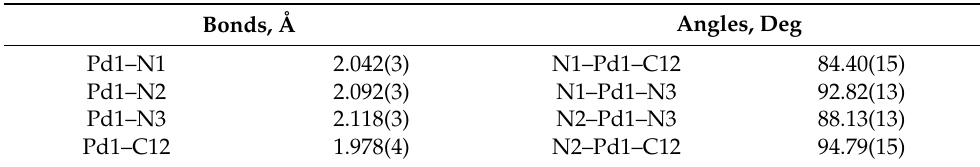
Figure 2. The molecular structure of 2b . Two neighboring cations are shown, Pd—CH3 contact is shown by dotted line. Noncoordinated mesylate anions and water molecules are not shown. Thermal ellipsoids are shown at 0.15 probability level. H atoms are omitted for clarity. Table 1. Selected bond length and angles in 2b.